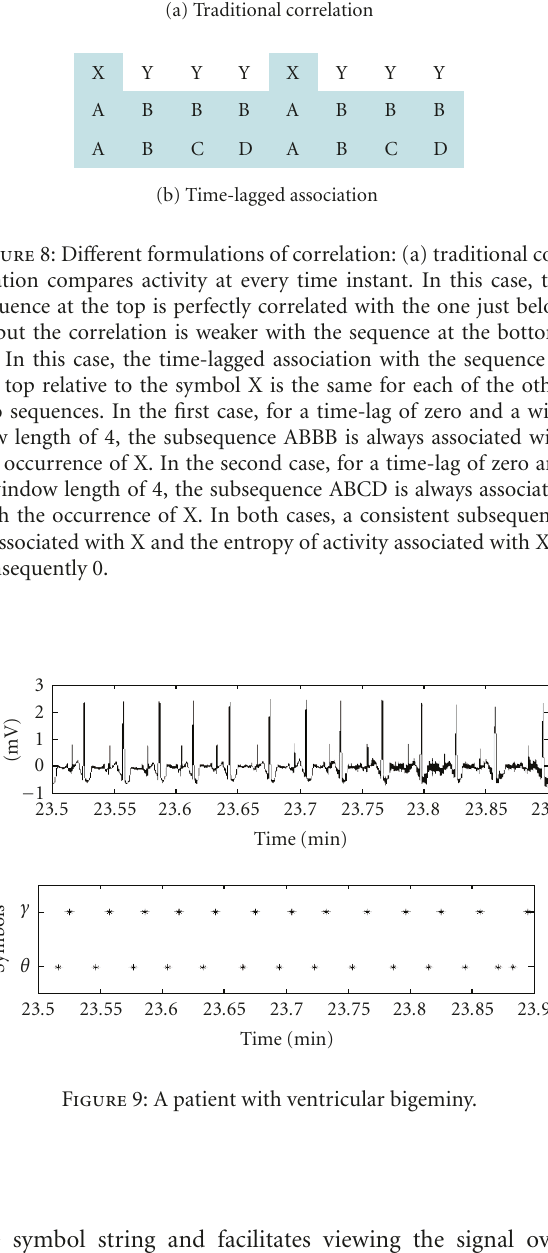
the symbol string and facilitates viewing the signal over long time intervals. In each case, the repeating sequence in the symbolic signal corresponds to a well-known cardiac rhythm that can be recognized in the raw tracings. Figure 9 presents a signal showing a ventricular bigeminy pattern, while Figure 10 shows trigeminy. The associated symbolic streams provided for both figures show the repetitious ac- tivity in the reduced symbolic